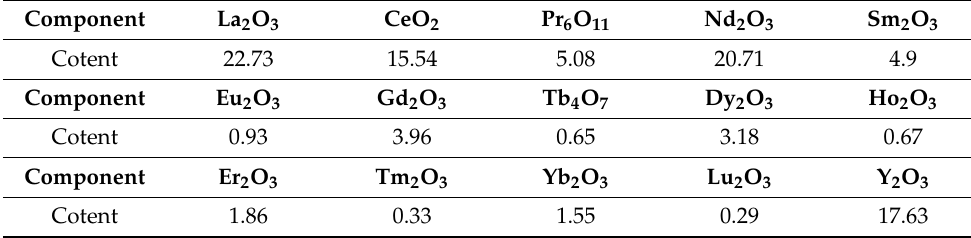
Table 1. Rare-earth partitioning of the ion-exchangeable phase of ore samples (wt%).